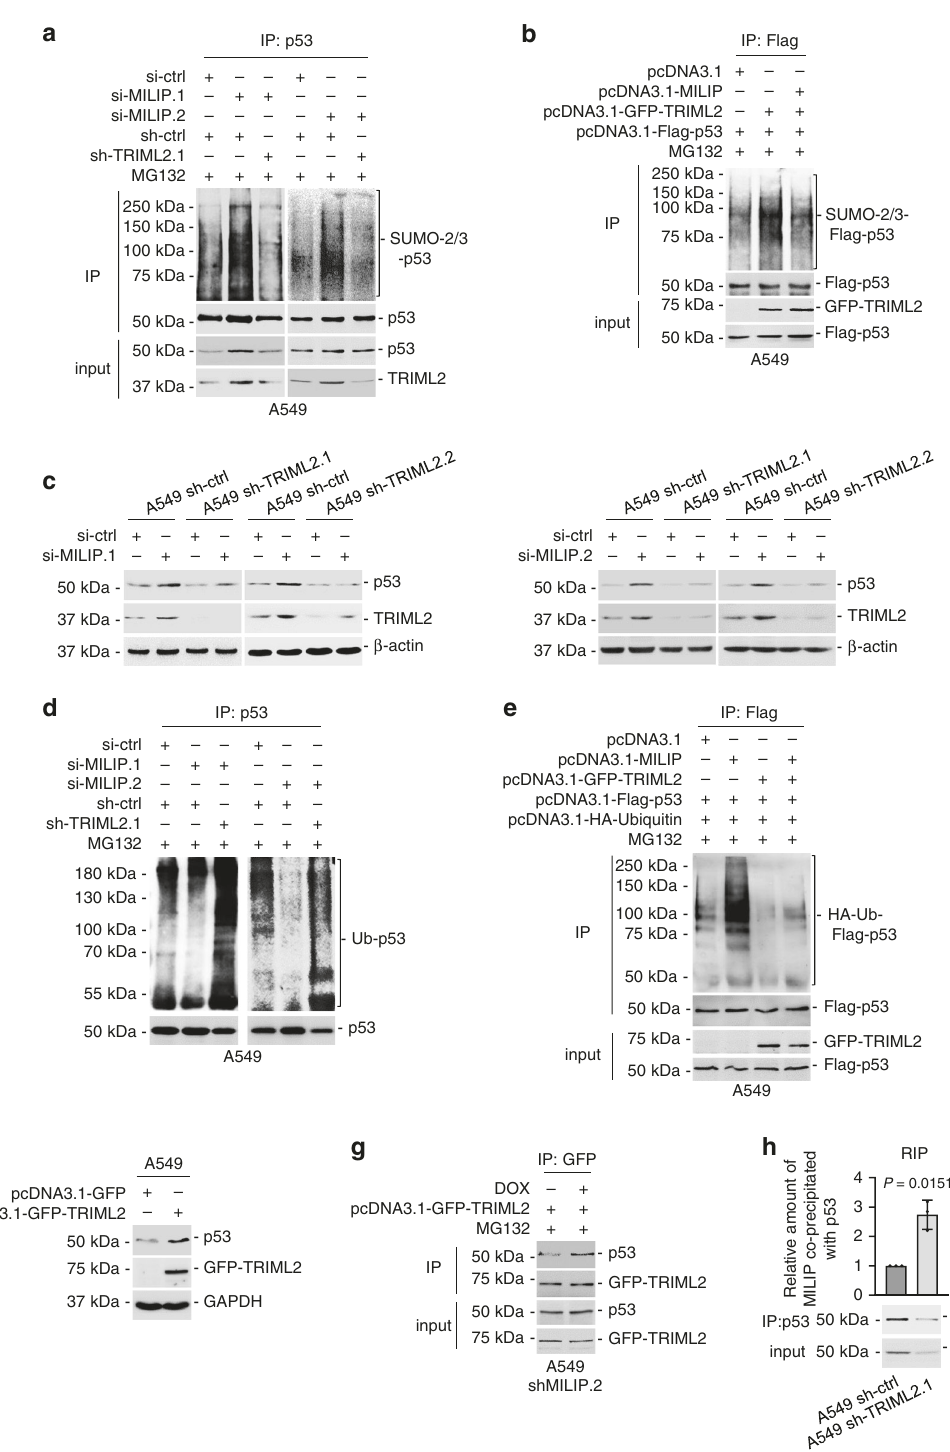
Fig. 4 MILIP promotes p53 polyubiquitination through supressing TRIML2-mediated p53 SUMOylation. a Knockdown of MILIP increased modi fi cation of p53 by SUMO-2/3, which was abolished by co-knockdown of TRIML2. Data shown represent three independent experiments. MG132: 10 µ M. b TRIML2 overexpression increased p53 SUMOylation, which was diminished by co-overexpression of MILIP. Data shown represent three independent experiments. MG132: 10 µ M. c Knockdown of MILIP upregulated p53, which was diminished by co-knockdown of TRIML2. Data shown represent three independent experiments. d Knockdown of MILIP-reduced p53 polyubiquitination, which was reversed by TRIML2 co-knockdown. Data shown represent three independent experiments. MG132: 10 µ M. e MILIP overexpression increased p53 polyubiquitination, which was abolished by overexpression of TRIML2. Data shown represent three independent experiments. MG132: 10 µ M. f Overexpression of TRIML2 upregulated p53. Data shown represent three independent experiments. g Knockdown of MILIP increased the amount of TRIML2 bound to p53. Data shown represent three independent experiments. IP immunoprecipitation. The proteasome inhibitor MG132 was used at 10 µ M. h Knockdown of TRIML2 increased the amount of MILIP bound to p53. Data are representatives or mean ± s.d.; n = 3 independent experiments, two-tailed Student ’ s t test. Source data of Fig. 4a – h are provided as a Source Data fi